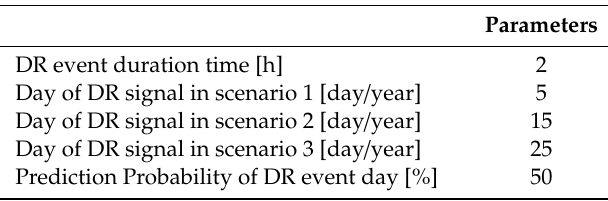
Table 2. Monte Carlo Simulation (MCS)